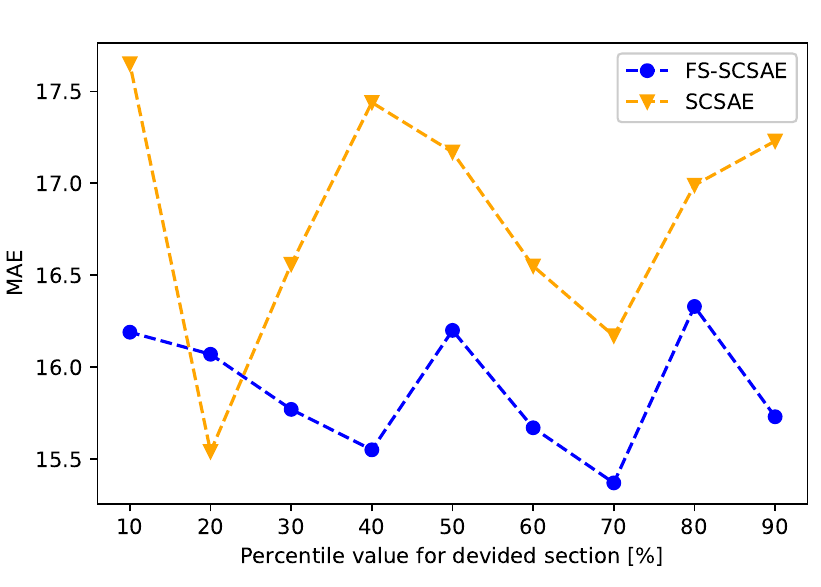
Figure 11. Comparison of reconstruction errors (MAEs) of the existing and proposed methods at different